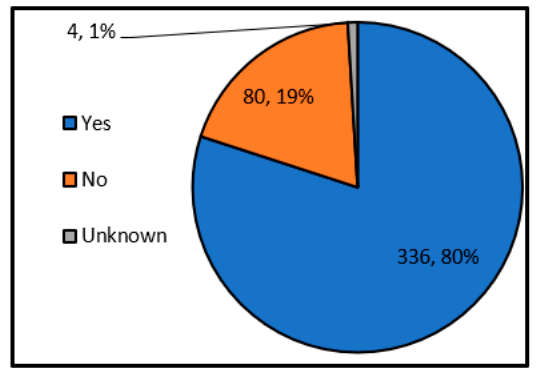
Figure 5. Presence or absence of undesignated shelters (single answer) (Single answer, total number of answers 420, total number of local governments: 420, unit: group). answers 420, total number of local governments: 420, unit: